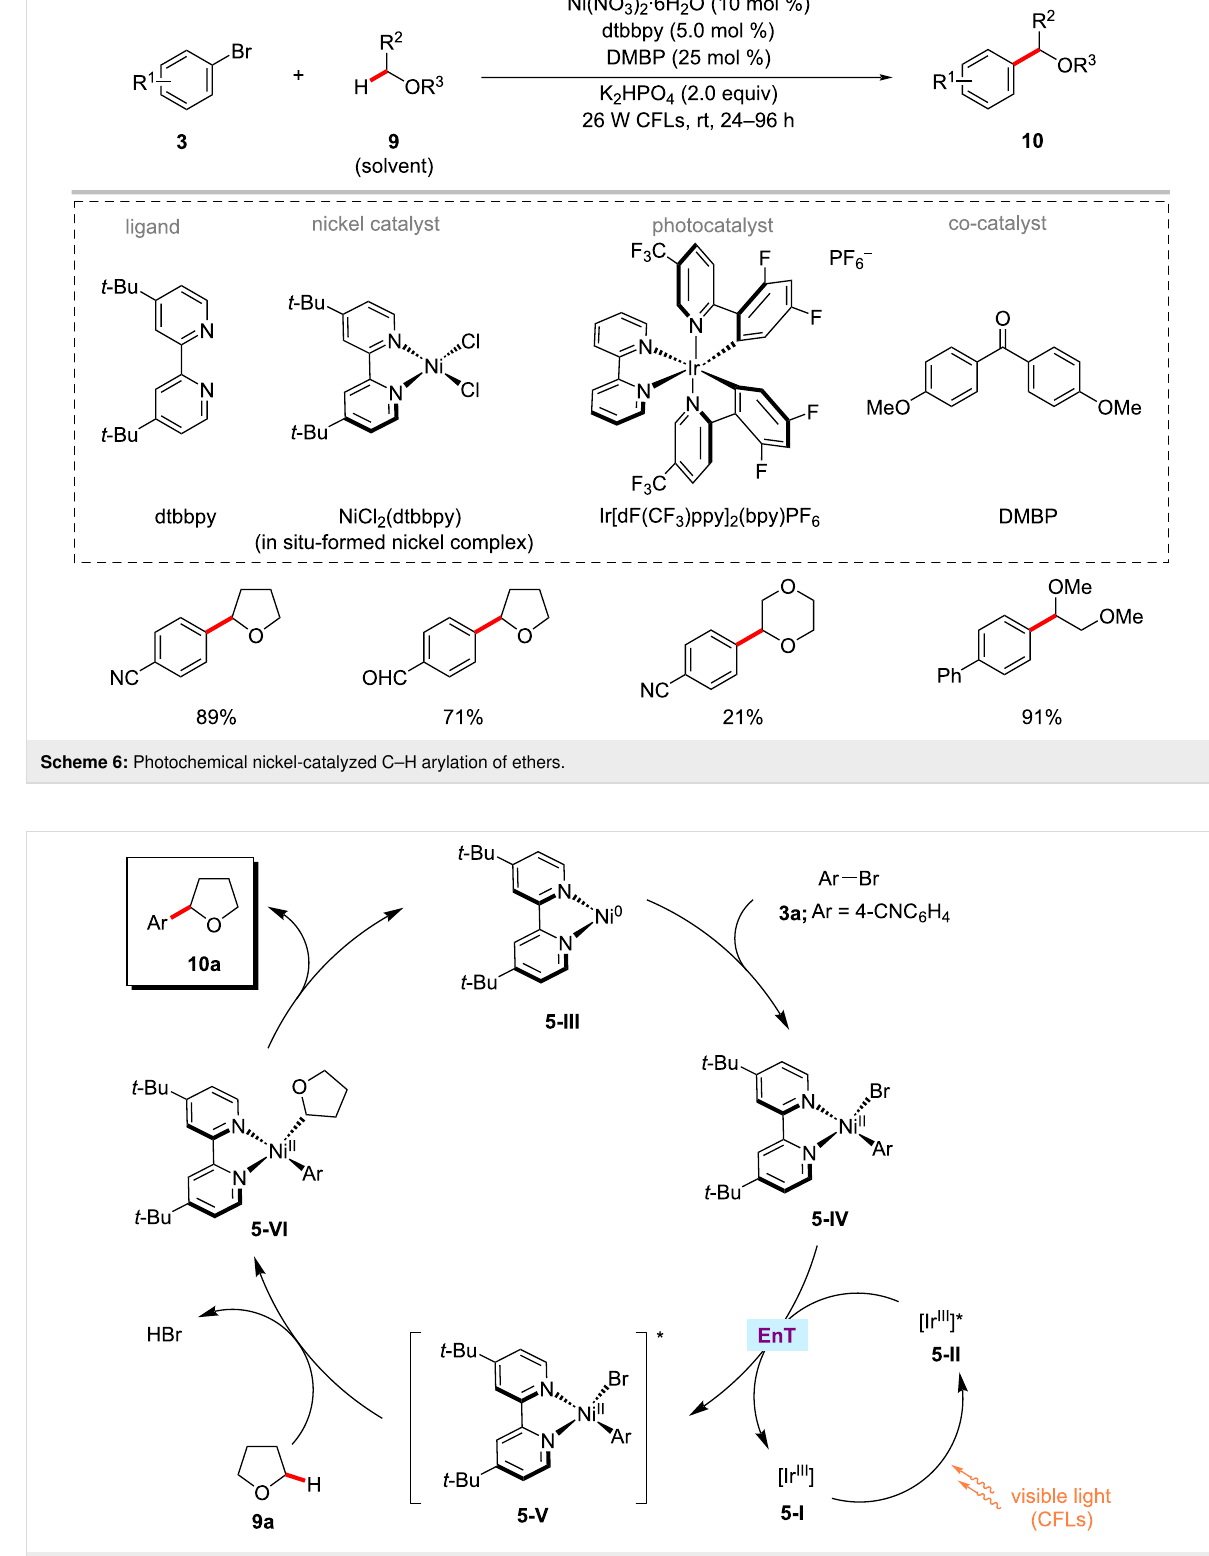
Figure 5: Proposed catalytic cycle for the nickel-catalyzed arylation of ethers with aryl